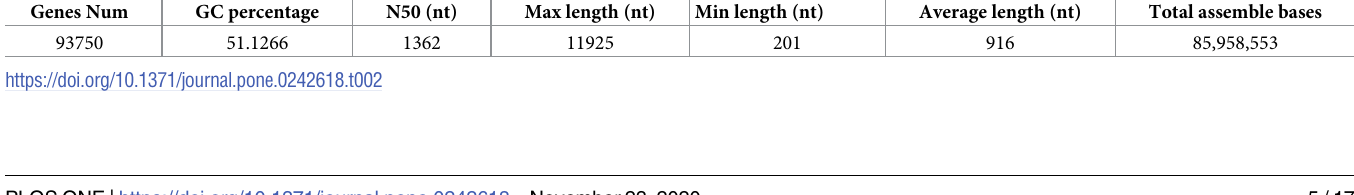
Table 2. Assembly result statistics of Pennisetum setaceum ‘Rubrum’. Genes